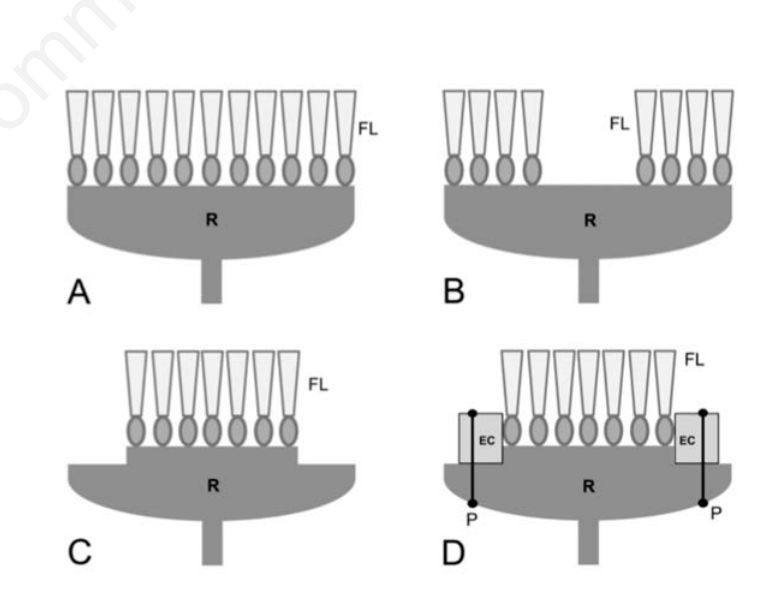
Figure 1. Schematic representation of the four treatments control (A), inner flowers removed (IR; B), outer flowers removed, (OR; C) and outer flowers removed plus external constraint (OR+PC; D), applied to capitula of sunflower in the experimental manipula- tion of flower competition. EC: Styrofoam ring to apply an artificial external constraint to the middle ovaries; R: receptacle; FL: florets; P: fixing pins of the EC onto the recep- tacle